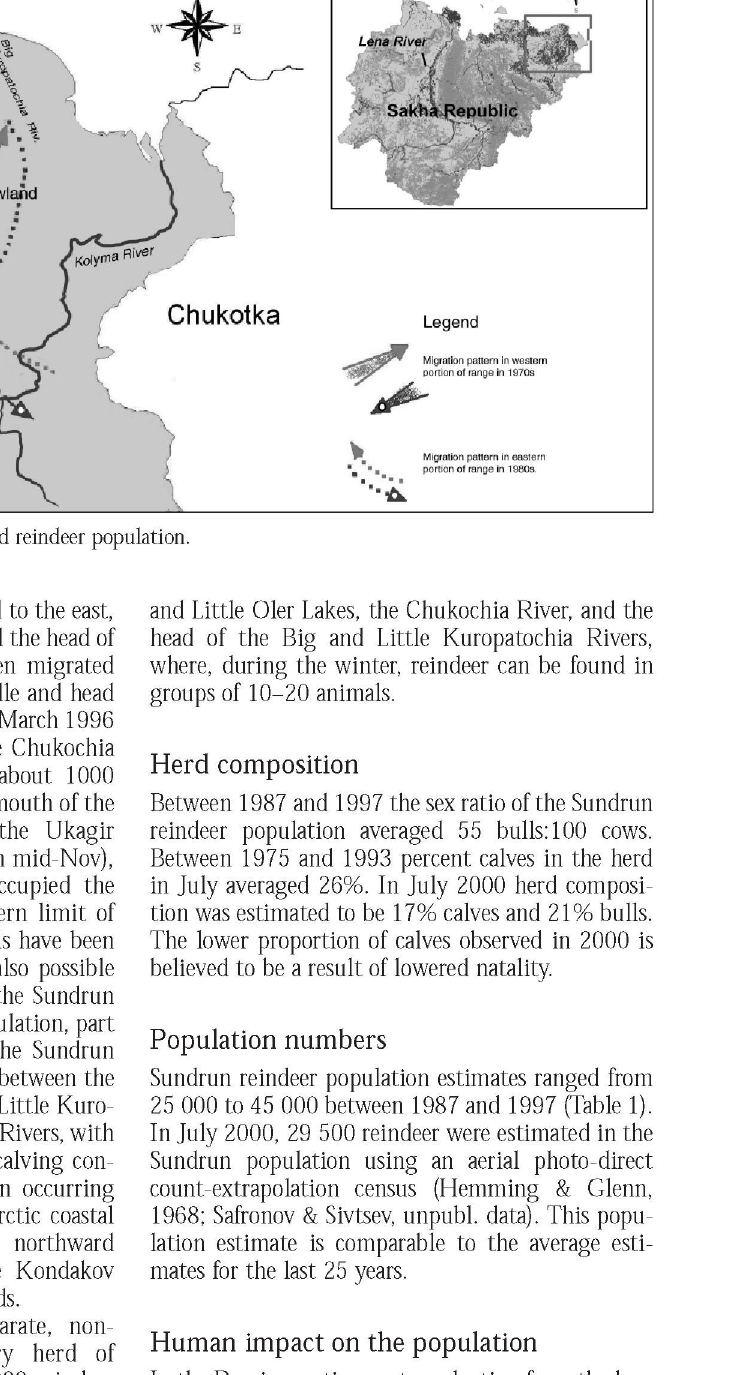
Sundrun wild reindeer the postcalving con- population, 1982-2000. centration occurring on the arctic